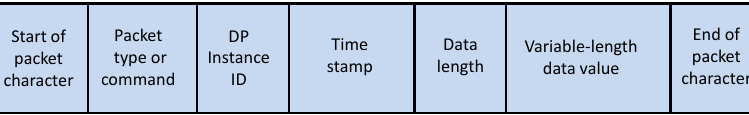
Figure 8. Definition of the Data Packet structure used to exchange telemetry.